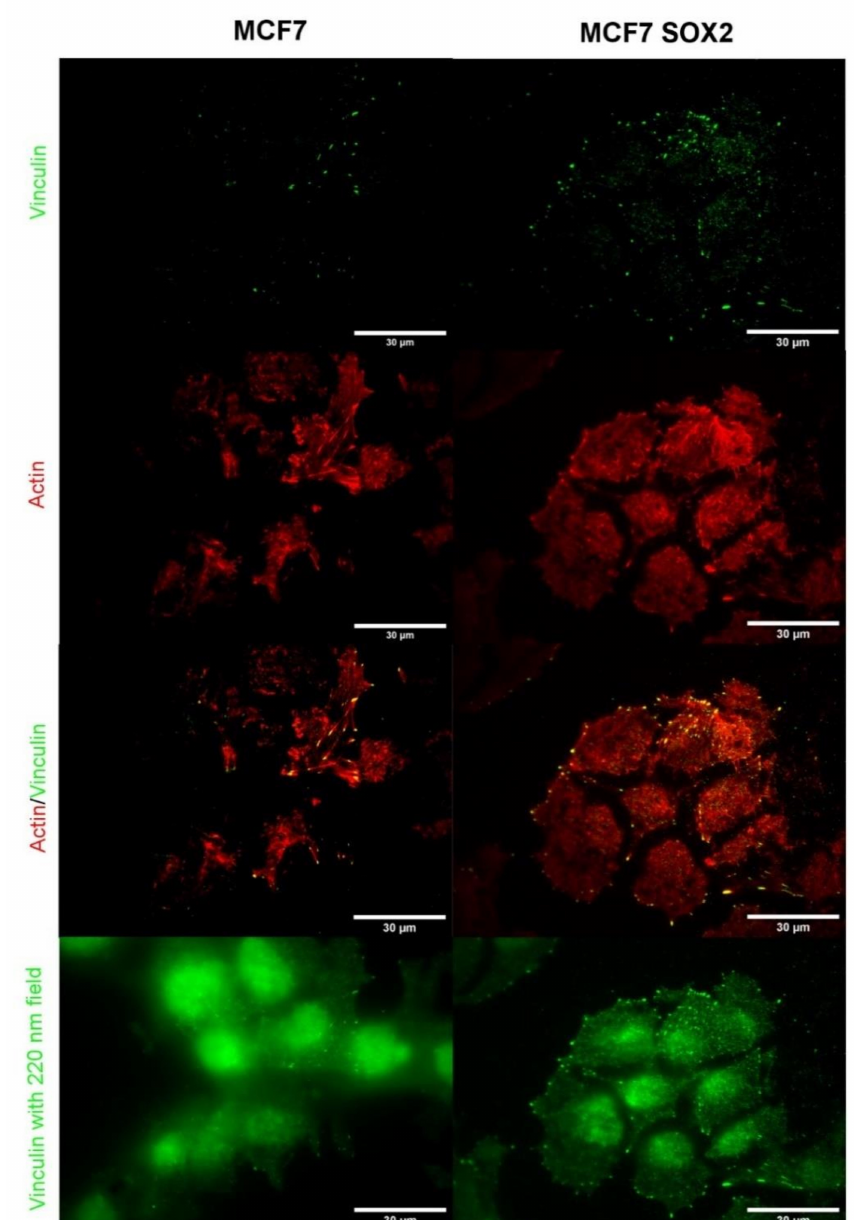
Figure 7. Total Internal Fluorescence Microscopy (TIRF) images of MCF7 and Sox2-overexpressing cells for individual actin (in red) and vinculin (in green) channels, and the merged image. An evanescent field of 90 nm was used while keeping the illumination time constant. The bottom image shows a wide (220 nm) field applied on the same area of